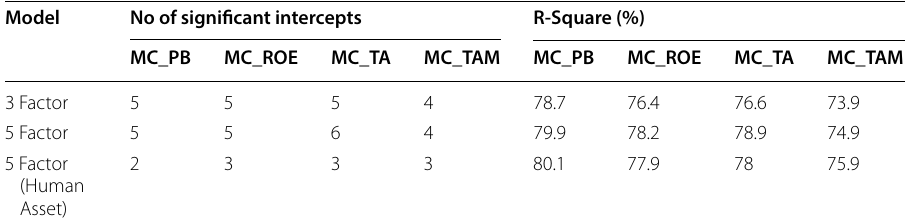
Table 7 Summary of the factor regressions Model